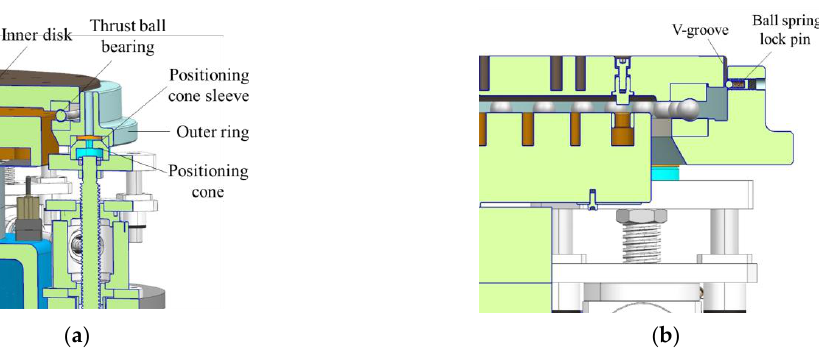
Figure 13. ( a ) The schematic of non-measuring state; ( b ) The detail view of non-measuring state. ⚫ The mass centroid measurement state